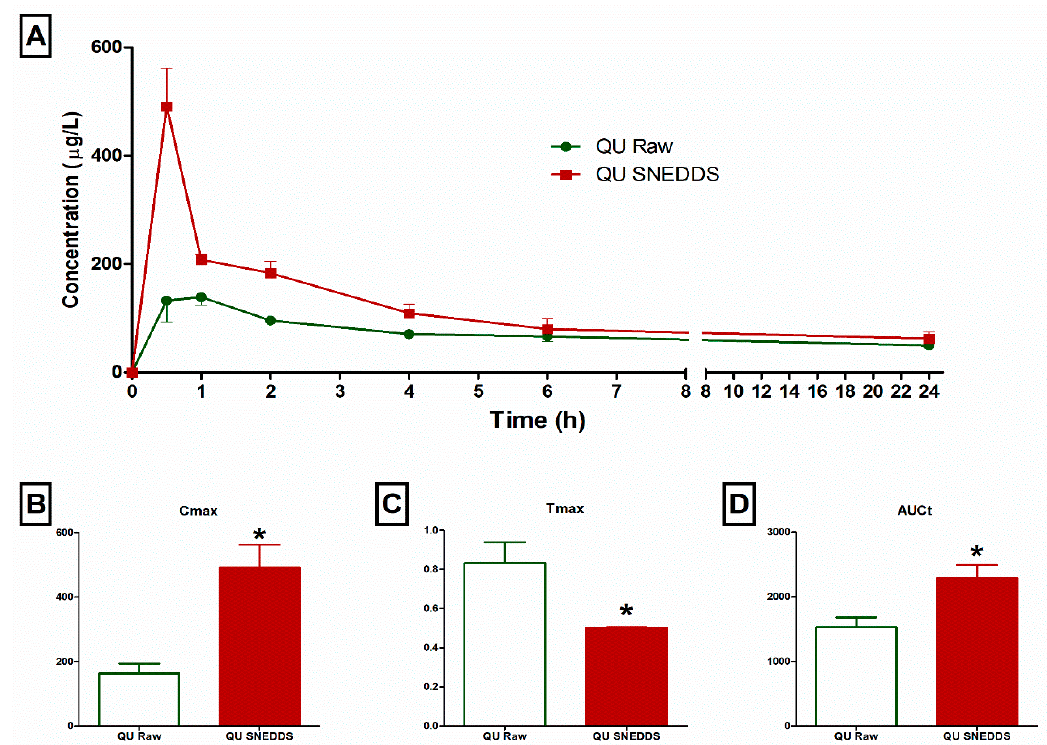
Figure 6. Plasma concentration of quercetin (QU) within 24 h after administration of QU SNEDDS formula and QU suspension, A . Comparison of C max , B , T max , C , and AUCt, D . Data presented as mean ± SEM, n = 7 animals, * Significantly different ( p < 0.05).